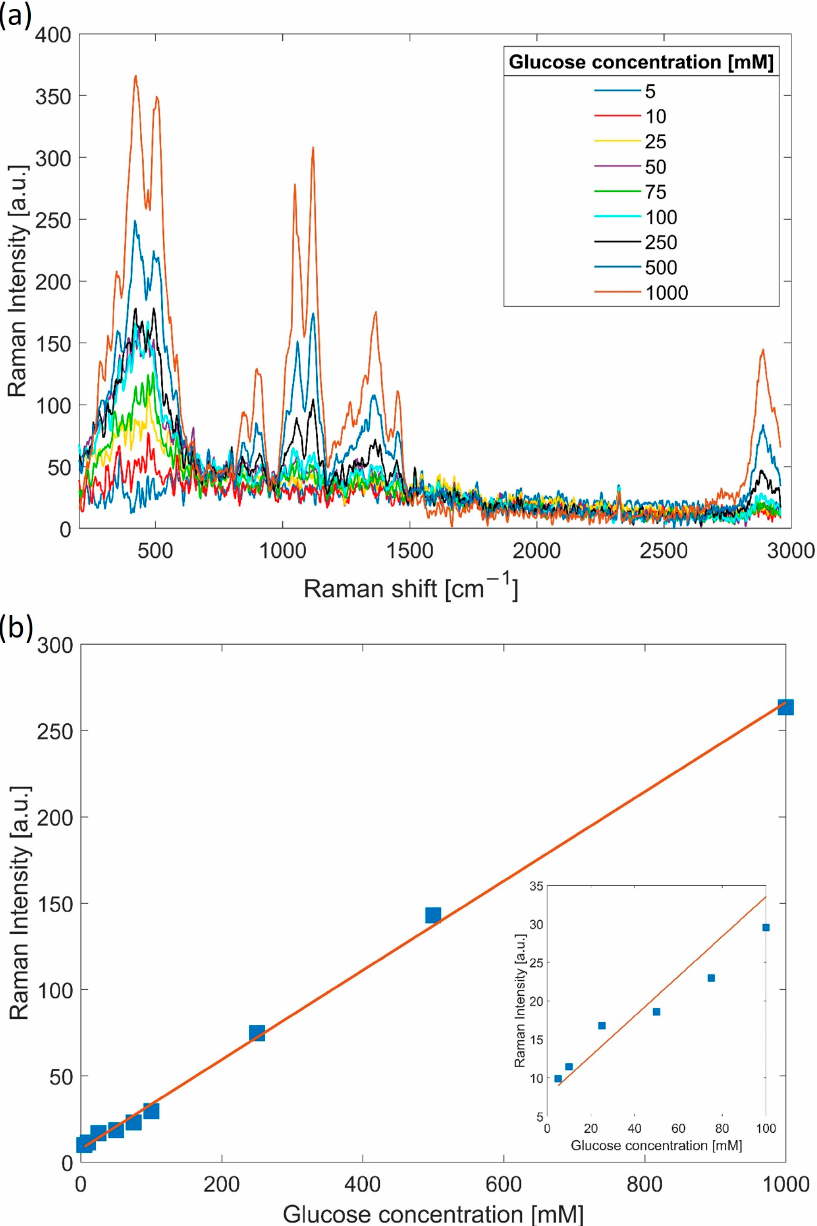
Figure 6. ( a ) Measured Raman spectra for different glucose concentrations; ( b ) 1120 cm − 1 peak intensity as a function of the glucose concentration in mM (blue points) and linear fit (red). Insert: closeup of concentration range 5–100 mM.